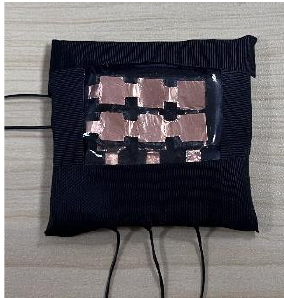
Figure 3. Prototype of the porous graphene flexible tactile sensor array.